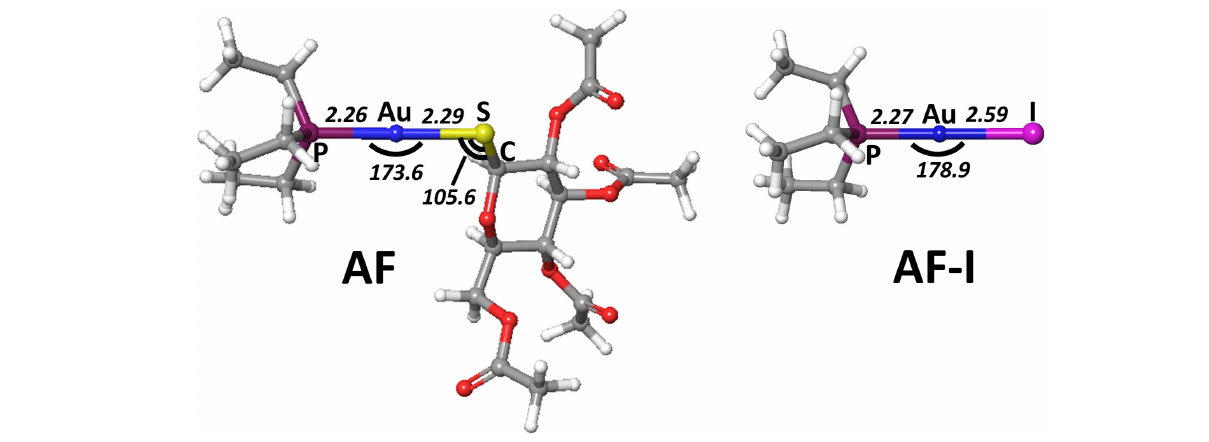
FIGURE 4 | Representation of the experimentally characterized structures of AF and AF-I complexes, the respective crystallographic cartesian coordinates are extrapolated from ( Hill and Sutton, 1980; Marzo et al., 2017). All distances are in angstroms, all angles in